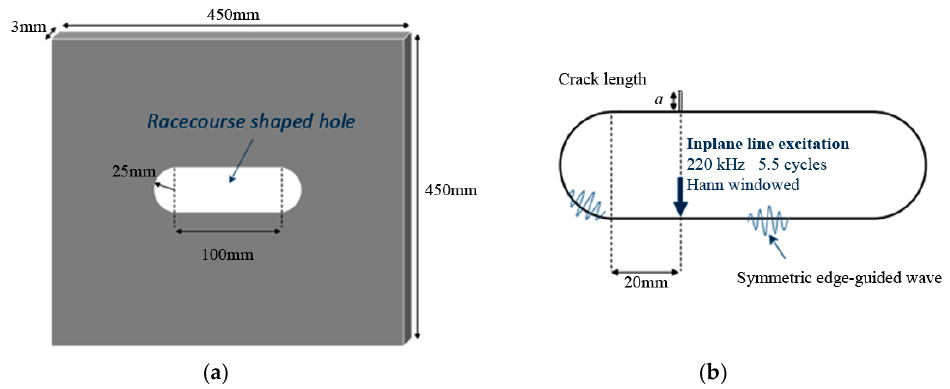
Figure 1. ( a ) Model configuration of the racecourse shaped hole centre in a 450 mm × 450 mm × 3 mm aluminium plate; ( b ) Close-up diagram of the racecourse shaped hole showing excitation and crack location.